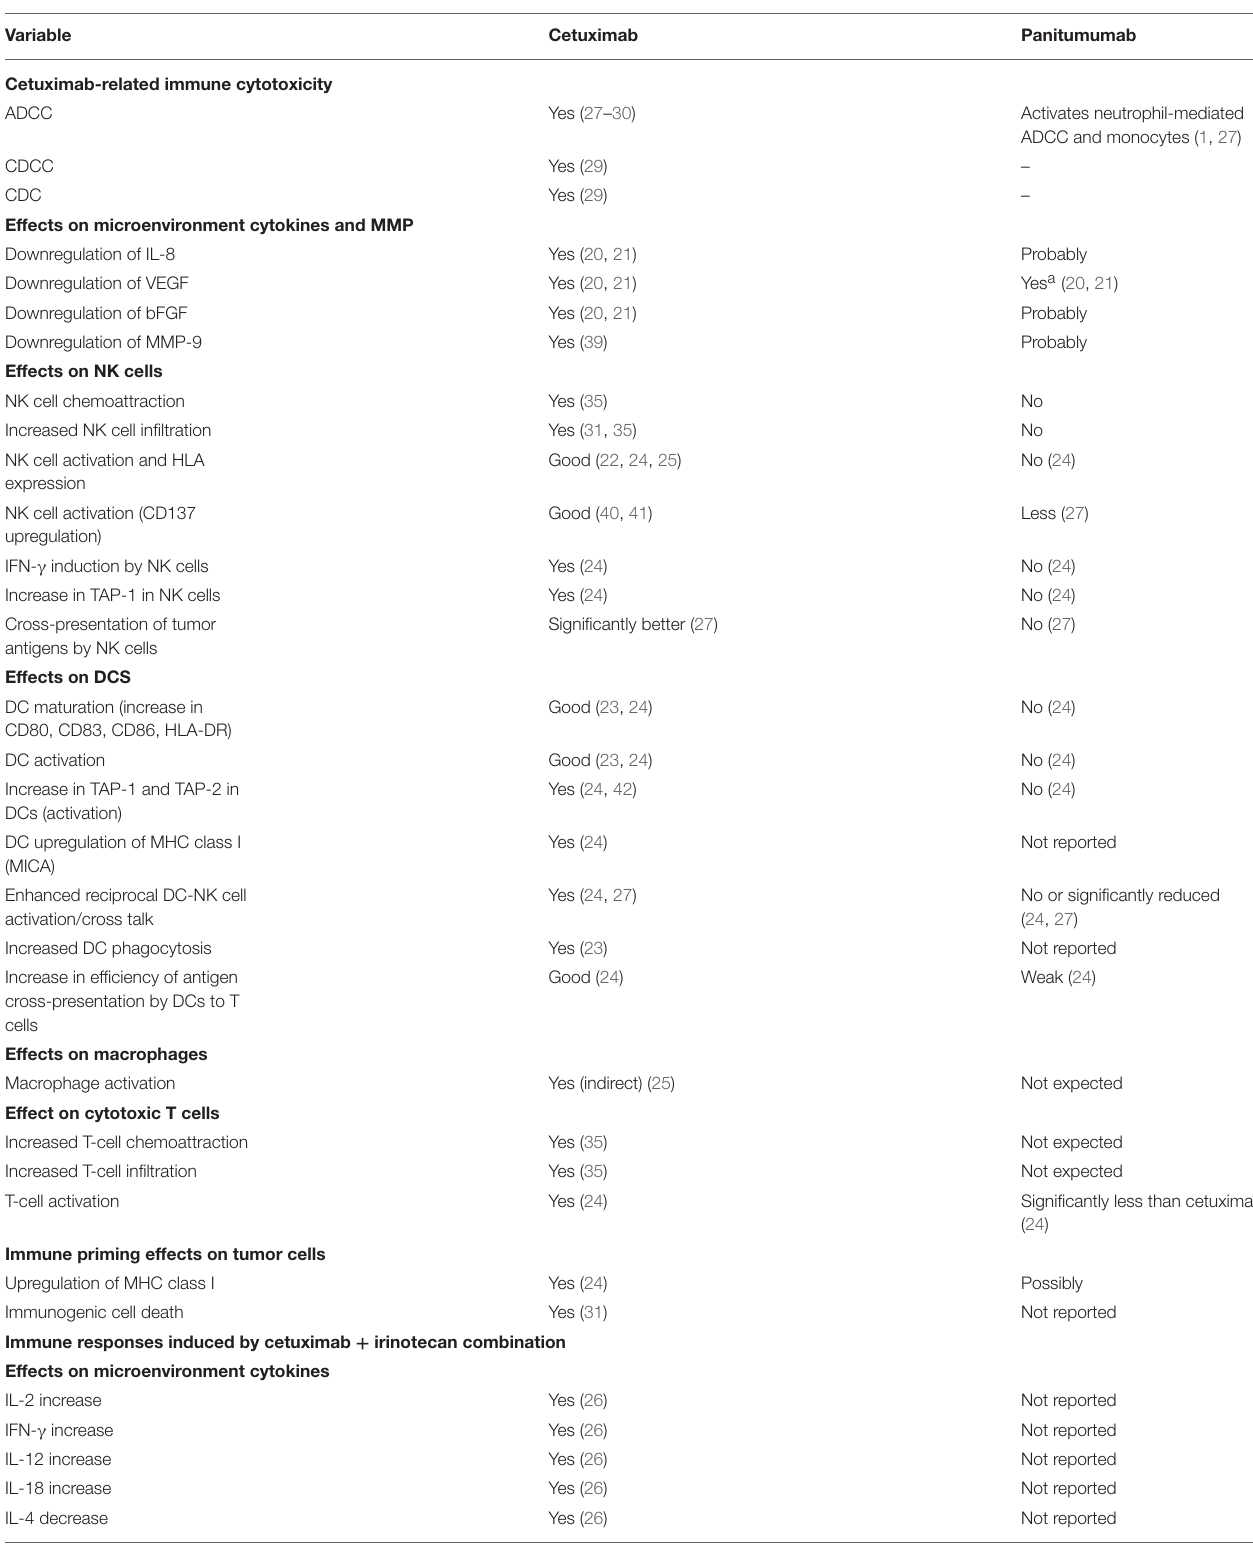
TABLE 2 | Cetuximab and panitumumab: differences in immune activation.